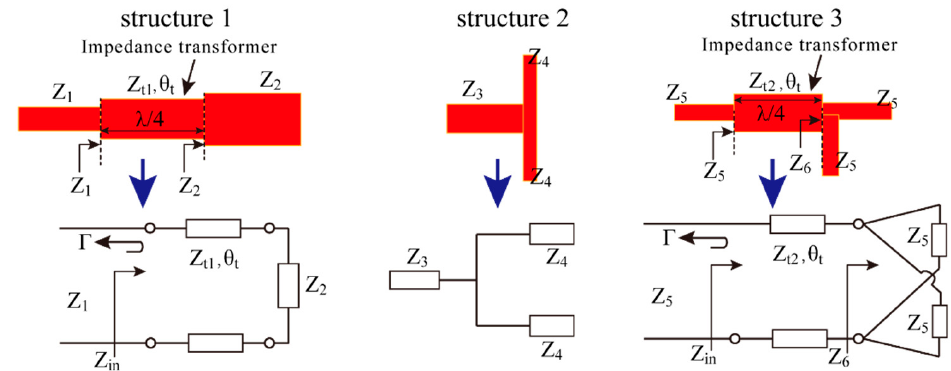
Figure 5. Three types of structures required to design the series feeding network and their corre- sponding equivalent circuit models.